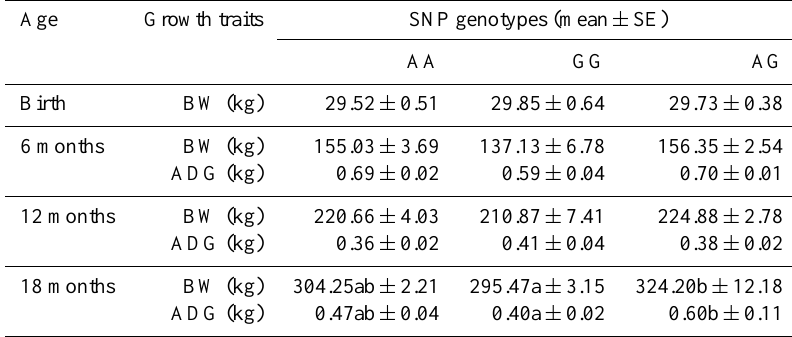
Table 4. Significant associations of SNP at c.605A>G locus with growth traits in Nanyang